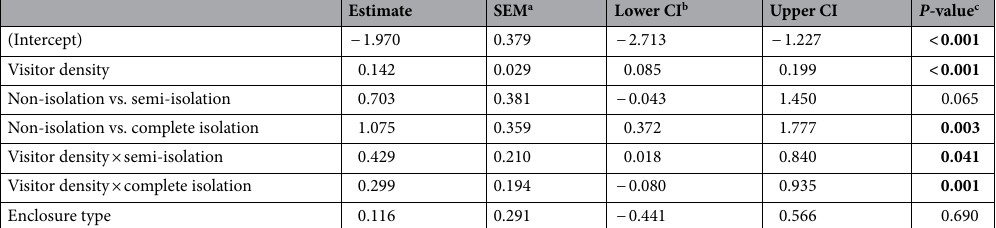
Table 3. Effect of visitor density and social isolation on the stress-related behaviors of gibbons (model 2a). *Visitor density (original mean ± SD = 5.13 ± 7.74); the reference level of the isolation phase is “non-isolation.” a SEM standard error of the mean. b CI confidence interval. c P -values in bold are